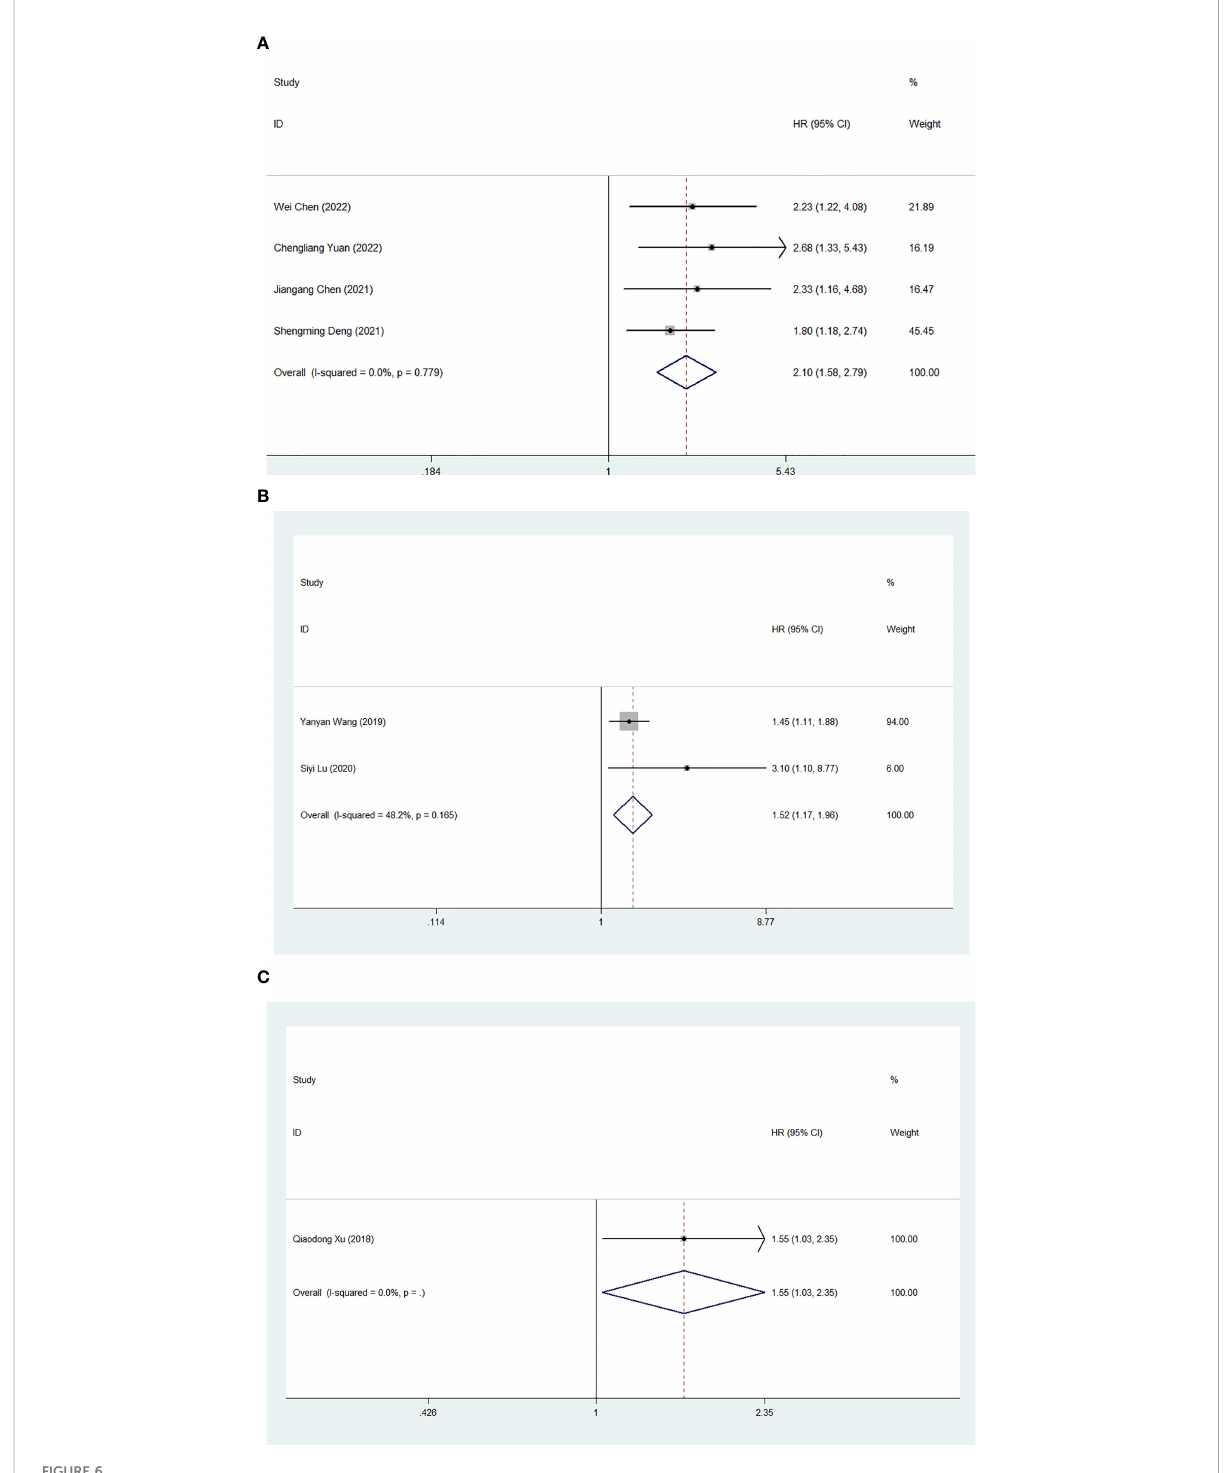
FIGURE 6 Forest plot for the association between FAR and progression-free survival (A) /disease-free survival (B) /time to recurrence (C)